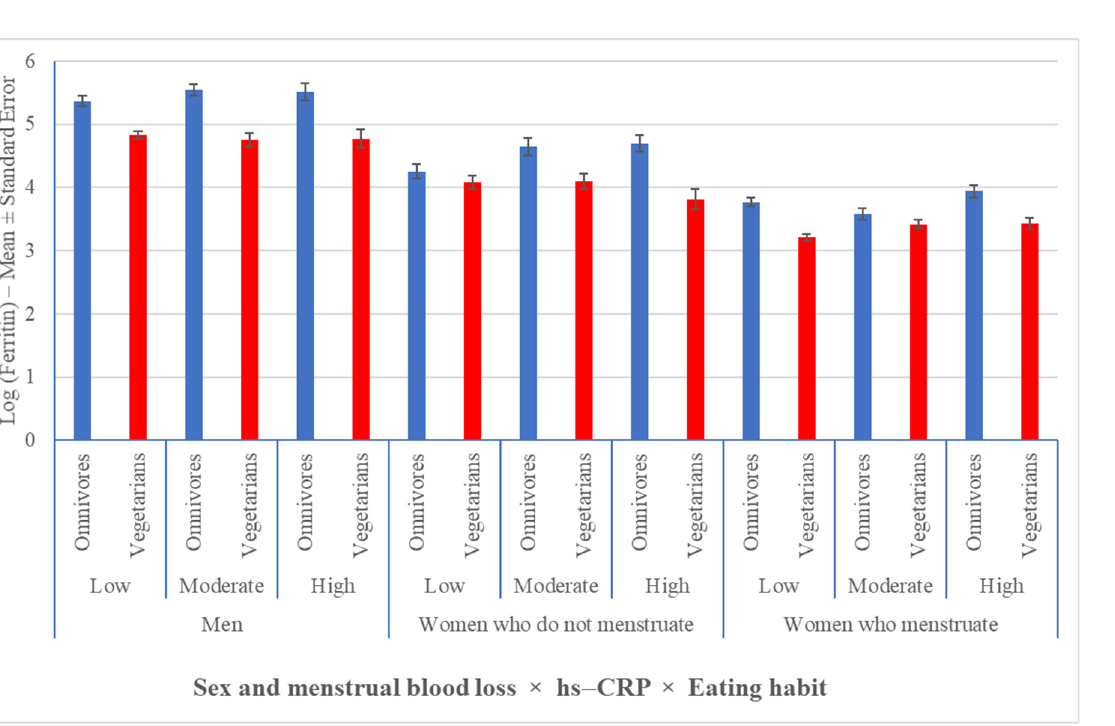
Table 2. Distribution of nutritional status based on eating habits.